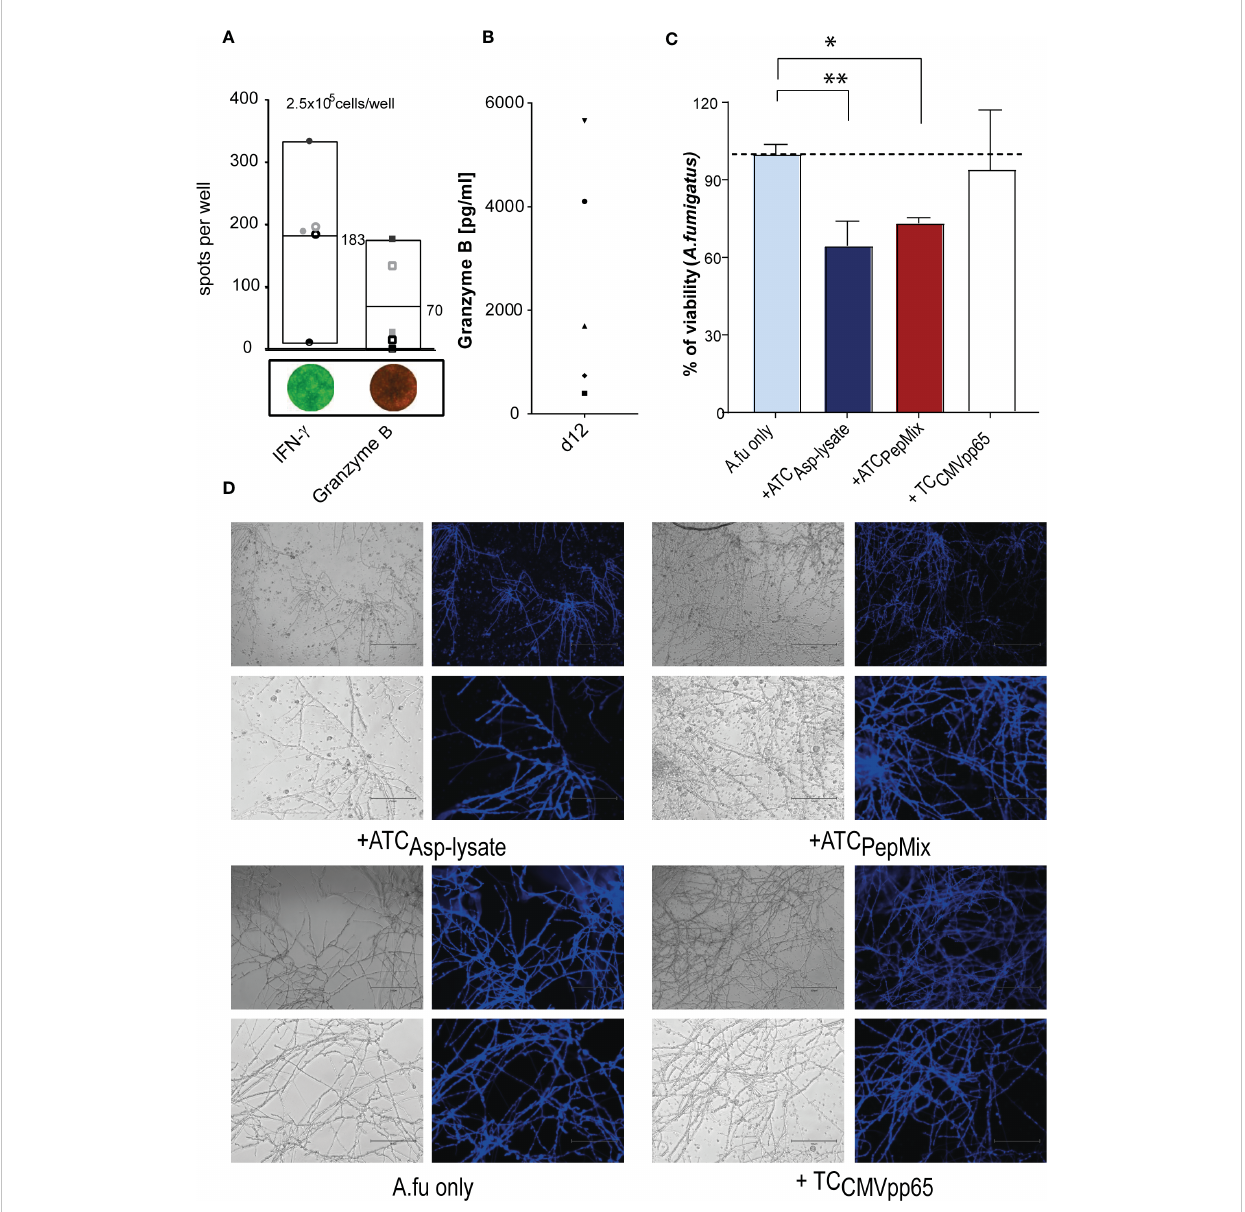
FIGURE 7 Functional and cytotoxic analyses of seATCs via FluroSpot assay and ELISA. PBMCs were short-term expanded (STE) for 12 days with Asp-lysate following Asp-restimulation for 16 hours with Asp-lysate (n=5). The cytotoxic activity of Asp-speci fi c T cells was investigated by means of IFN- g and granzyme B. (A) Numbers of IFN- g and granzyme B positive spots per 2.5 x 10 5 cells/well of ATCs with mean values represented via Box blots of fi ve individual HDVs including representative images of IFN- g (green) and granzyme B (red) secreting ATCs are shown. Results are given as the number of spots per well (spw), representing the number of spots in the antigen well after subtracting those of the respective negative control well. (B) The diagram shows individual values of granzyme B secretion (in pg/ml) in the supernatant of 12 days expanded ATCs, detected by ELISA (n=5). The different symbols represent the individuals ATCs from healthy donors who were pre-tested for the presence of Asp-speci fi c T cells. (C, D) . Aspergillus fumigatus hyphae were either left untreated (Afu only) or incubated for six hours with CMVpp65 peptide pool expanded T cells (+TC CMVpp65 ), as additional control, or Asp-lysate (+ATC Asp-lysate ) and PepMix-(+ATC PepMix ) speci fi c seATCs. Viability was analyzed by XTT reduction assay. The healthy individuals used belonged to our cohort of donors (n=320) who were pre-tested for the presence of Asp-speci fi c T cells. Results are displayed as mean±SD for samples from one representative healthy donor. Statistically signi fi cant difference is indicated by (*p<0.05 and **p<0.01). A.fu, Aspergillus fumigatus ; TC, T